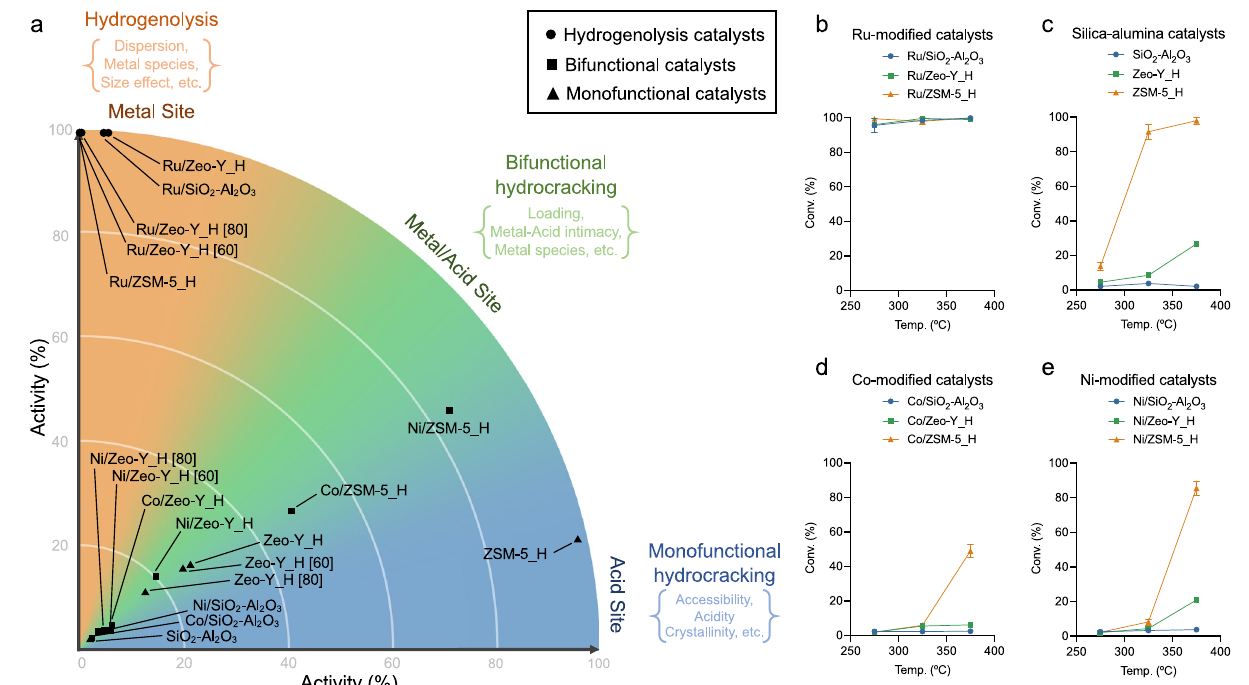
Fig. 5 | Activity-mechanism map and catalytic n- hexadecane (nC 16 ) decom- positionsviatypesofmetalmodi fi cations.a Activity-mechanismmapwiththe18 testedcatalystspositionedaccordingtotheiractivityandmechanism(notethatthe activity is denoted by the nC 16 conversion at the benchmark condition: 45 bar H 2 , 375°C, 2h). C-C bond cleavage is dominated by hydrogenolysis (orange area), bifunctional hydrocracking (green area), or monofunctional hydrocracking (blue area). b nC 16 (1.59g)deconstructionswith45barH 2 ,at275,325,and375°C,2h,via